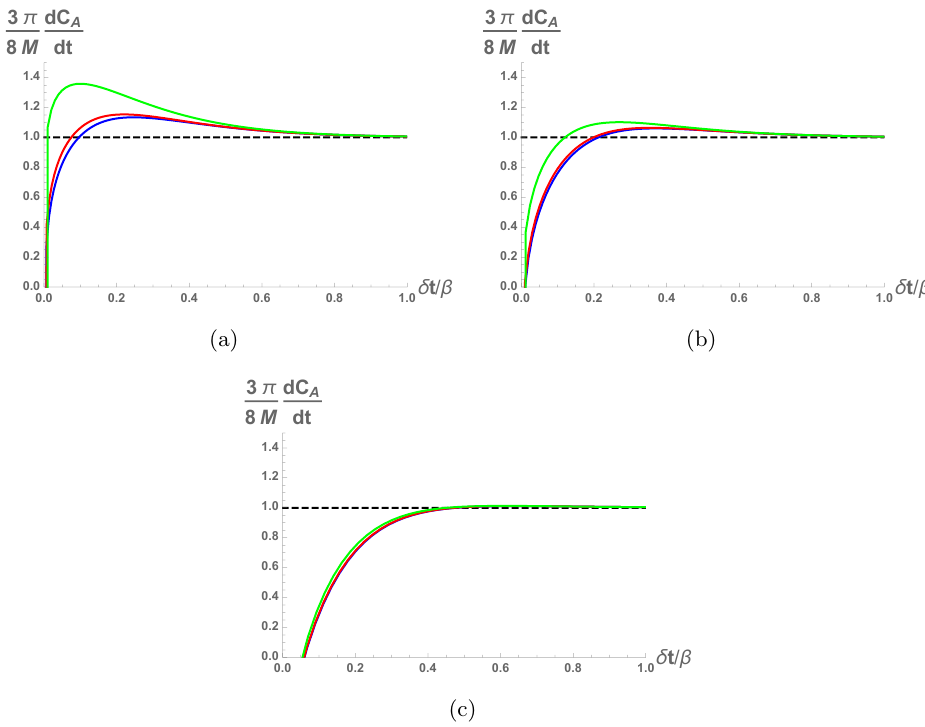
Figure 4 . dC A is plotted against the dimensionless quantity (cid:14)t=(cid:12) for d = 4 and n = 2. Here (cid:12) is dt inverse temperature. Panel (a) shows the variation of dC A (c) for r h = 3 : 5. In each panel blue, red and green curves correspond to a = 0 : 05, a = 0 : 1 and a = 0 : 5 respectively. In all cases, the dotted line represents the ratio 3 (cid:25) the constants c; (cid:22) c = 1 have been set for